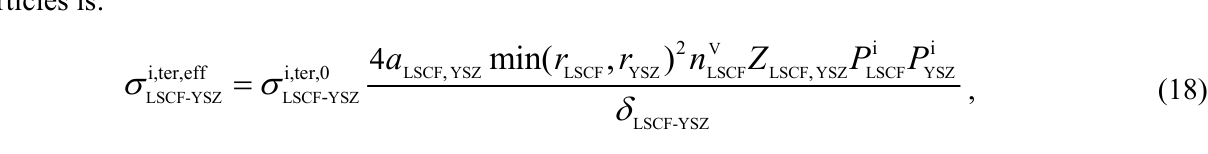
Figure 5. Comparison of the two different calculating methods used to obtain the inter-particle ion conductivity among the LSCF and YSZ particles when